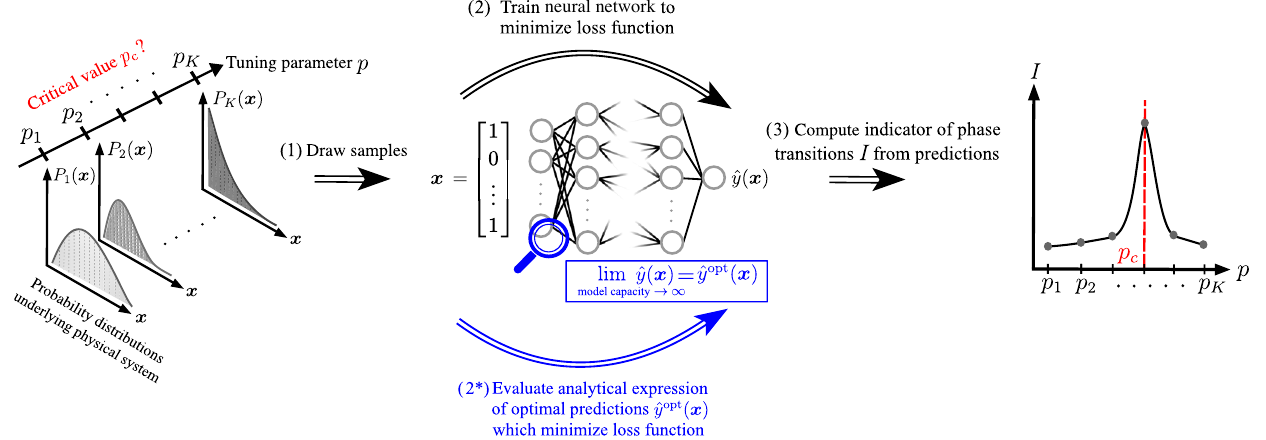
FIG. 1. Schematic representationofthe setupand work flow of supervised learning, the learning-by-confusion scheme, and the prediction- basedmethodfordetectingphasetransitionsfromdata.Thephysicalsystemunderconsiderationischaracterizedbyatuningparameter p .The at which the systemtransitions fromone phase to another. Ina firststep(step1), goal is toidentify the criticalvalueofthe tuningparameter p c , where the state x of the physical system is (repeatedly) sampled at various values of the tuning parameter f p 1 ; p 2 ; … ; p K g f P 1 ð x Þ ; P 2 ð x Þ ; … ; P K ð x Þg are the corresponding probability distributions. Based on these samples, a neural network (NN) is trained to performaparticularclassificationorregressiontask;i.e.,itstunableparametersareupdatedtominimizeaparticularlossfunction(step2).The threeMLmethodsfordetectingphasetransitionsdifferintheirformulationoftheunderlyingNNtasks.HavingtrainedtheNN,itspredictions ˆ y are usedtocompute thevalue ofanindicatorofphasetransitions I atfixed valuesofthe tuningparameter(step 3).Ideally,the indicator has a , where the largest change in the state of the system occurs. As a result, the ML methods then autonomously highlight local maximum at p c phase boundaries along the chosen scanning range of the tuning parameter. Note that the indicators of phase transitions obtained with supervisedlearning,thelearning-by-confusionscheme,andtheprediction-basedmethoddiffer.Thecontributionofourworkishighlightedin blue: We derive analytical expressions for the optimal predictions ˆ y opt of the NNs used in these three methods. The optimal predictions minimize the corresponding loss function and can, thus be achieved by NNs whose capacity, i.e., ability to fit a wide variety of functions [40,41], is sufficiently high. The optimal predictions can solely be expressed in terms of the probability distributions underlying the physical system. Using the optimal predictions ˆ y opt in place ofthe NNpredictions ˆ y , we further obtain analytical expressions forthe optimal indicators of phase transitions I opt (step 2*). Evaluating these analytical expressions provides an alternative path for computing indicators of phase transitions without ever training NNs; see Table I, where we compare the computation times of the two